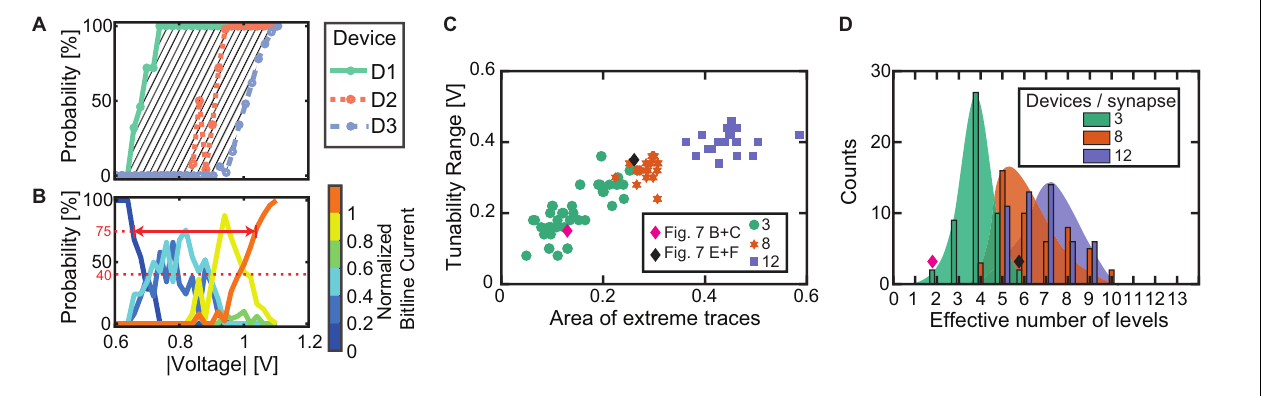
FIGURE 8 | (A,B) Sketch of the introduced analysis parameters based on the individual SET probability traces and the bitline current probabilities. The gray shaded area in (A) shows the first parameter, while the solid red line in (B) shows the second and the dashed red line in (B) shows the third. (C) Dependence between tunability range and extreme trace area for the simulations comprising 50 instances of 3, 8, and 12 devices each. (D) Statistics of the effective number of addressable intermediate bitline current ranges for each synapse